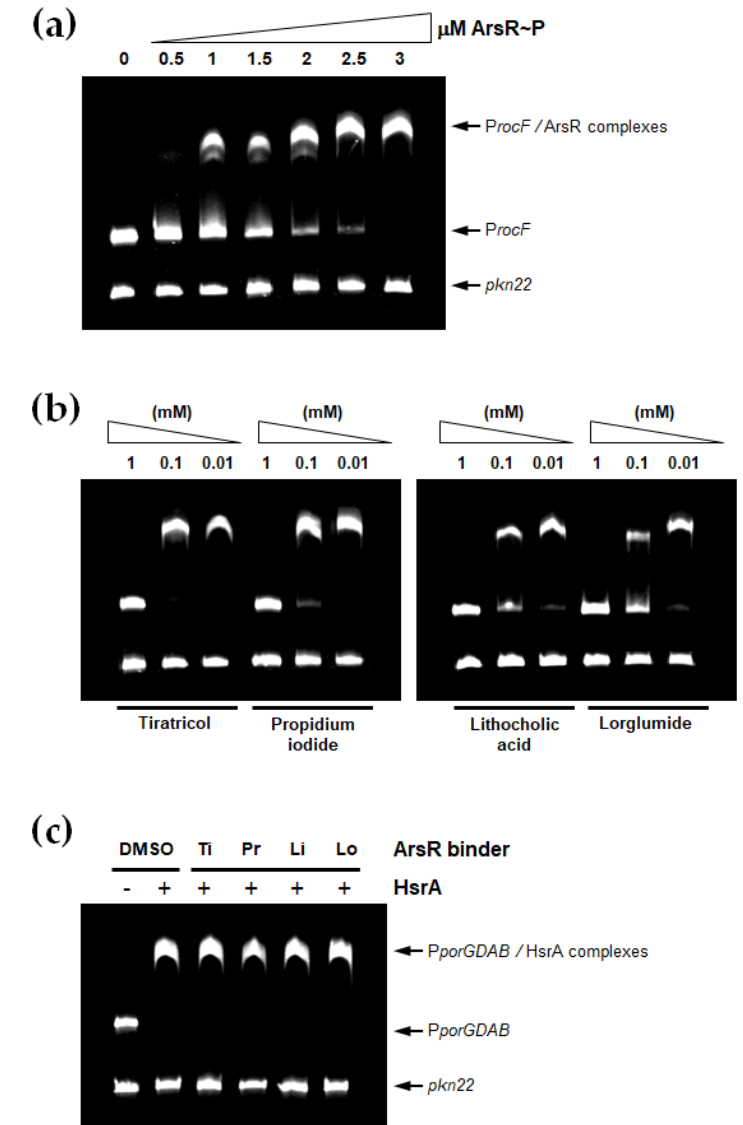
Figure 2. Non-antibiotic FDA-approved drugs inhibited the DNA binding activity of ArsR. ( a ) EMSAs showing the ability of the in vitro phosphorylated regulator (ArsR~P) to specifically bind the promoter region of target rocF gene. Increasing concentrations of ArsR~P (indicated in µM) were mixed with 120 ng of target promoter and separated on a 6% PAGE. The Anabaena gene pkn22 was included as non-specific competitor DNA in all assays. ( b ) DNA fragments were mixed with 3 µM of recombinant ArsR~P in the presence of 1, 0.1 and 0.01 mM of each ArsR binder. ( c ) 120 ng of the promoter region of porGDAB operon were mixed with 6 µM of recombinant HsrA protein in the absence (DMSO) or presence of 1 mM of tiratricol (Ti), propidium iodide (Pr), lithocholic acid (Li) or lorglumide (Lo), and separated on a 6% PAGE. The Anabaena gene pkn22 was included as non-specific competitor DNA in all assays.